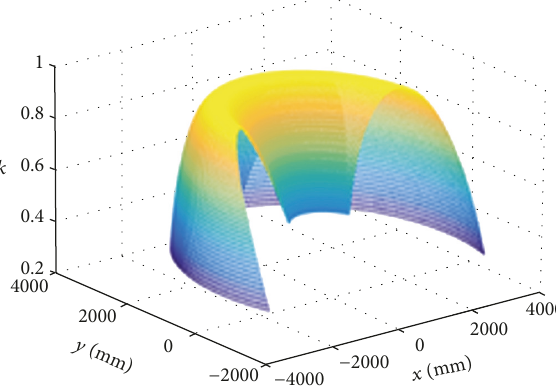
Figure 10: Transmission performance of the robot.